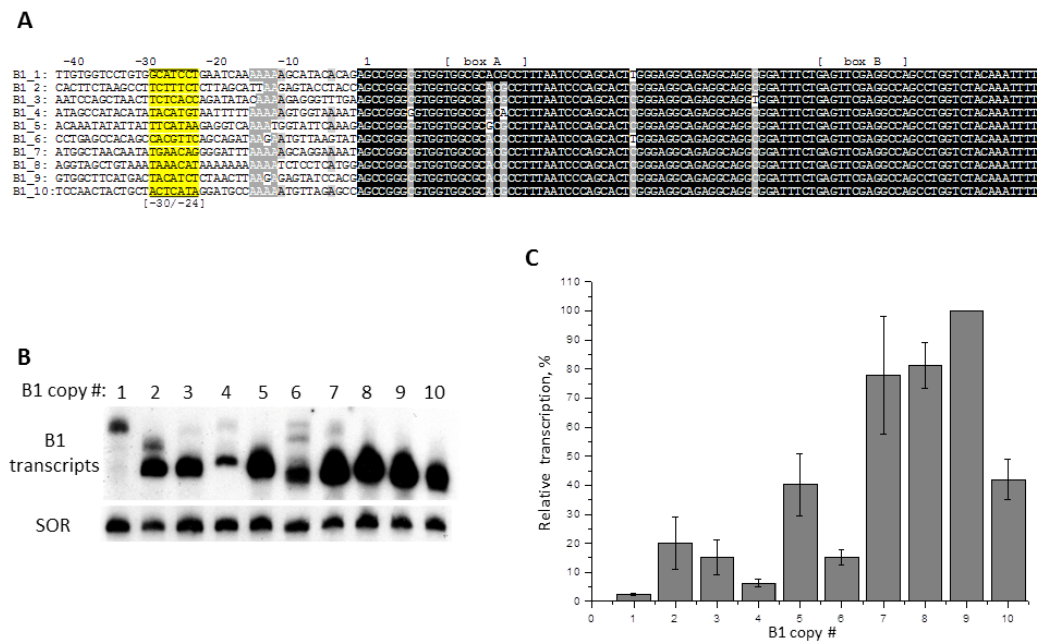
Figure 7. Transcription of 10 similar copies of B1 SINE from murine genome introduced to HeLa cells. ( A ) Nucleotide sequences of the 3 ′ -truncated B1 copies (mini-B1s) with their 5 ′ -FSs. The A and B boxes of pol III promoter and the − 30 / − 24 region sequences are labeled. ( B ) The transcripts of mini-B1 detected by Northern hybridization in the transfected cells. The numbers of B1 copies are indicated above the lanes. ( C ) Quantitative analysis of Northern hybridization results. The level of B1_9 copy transcription is taken as 100% (error bars, SD, n = 3).